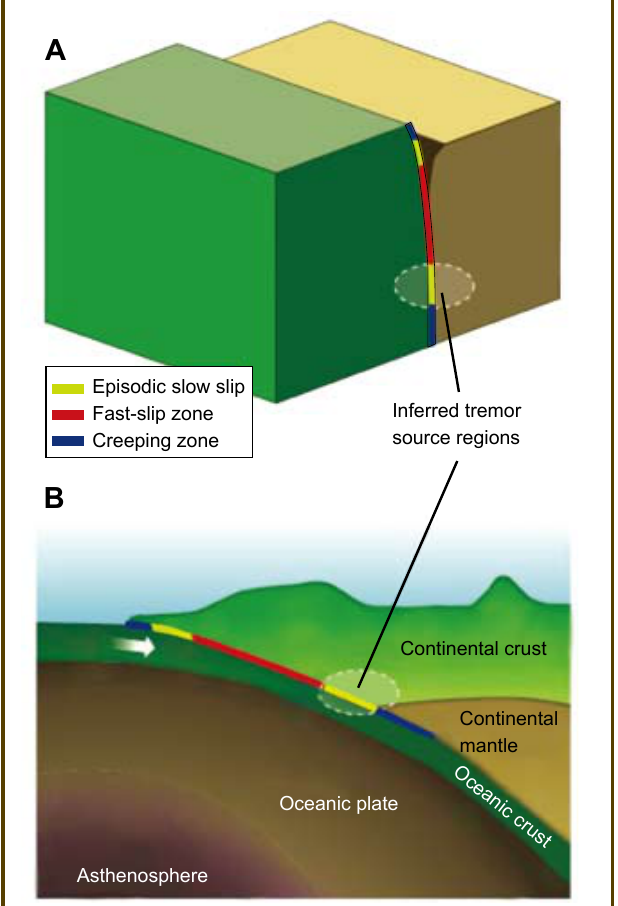
Figure 4. Locations of brittle fast-slip (seismogenic) and slow-slip zones: [A] Vertical strike slip fault; [B] Subduction zone. The new paradigm in earthquakes includes not only classically understood locked zones that break in fast slip producing earthquakes and adjacent creeping zones that nearly continuously deform without generating earthquakes, but also faults with episodic slow-slip zones that produce tremors. Additionally some subduction zones generate tsunami earthquakes that produce inordinately large tsunamis compared to the size of the earthquake (from Kanamori,